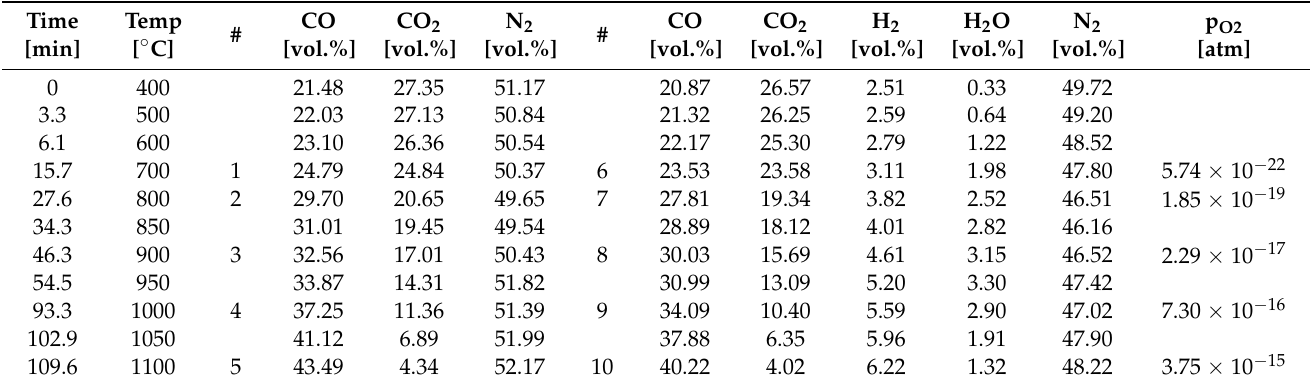
Table 2. Experimental program for the wall profile. Time information is cumulative and valid only for non-isothermal tests (numbered